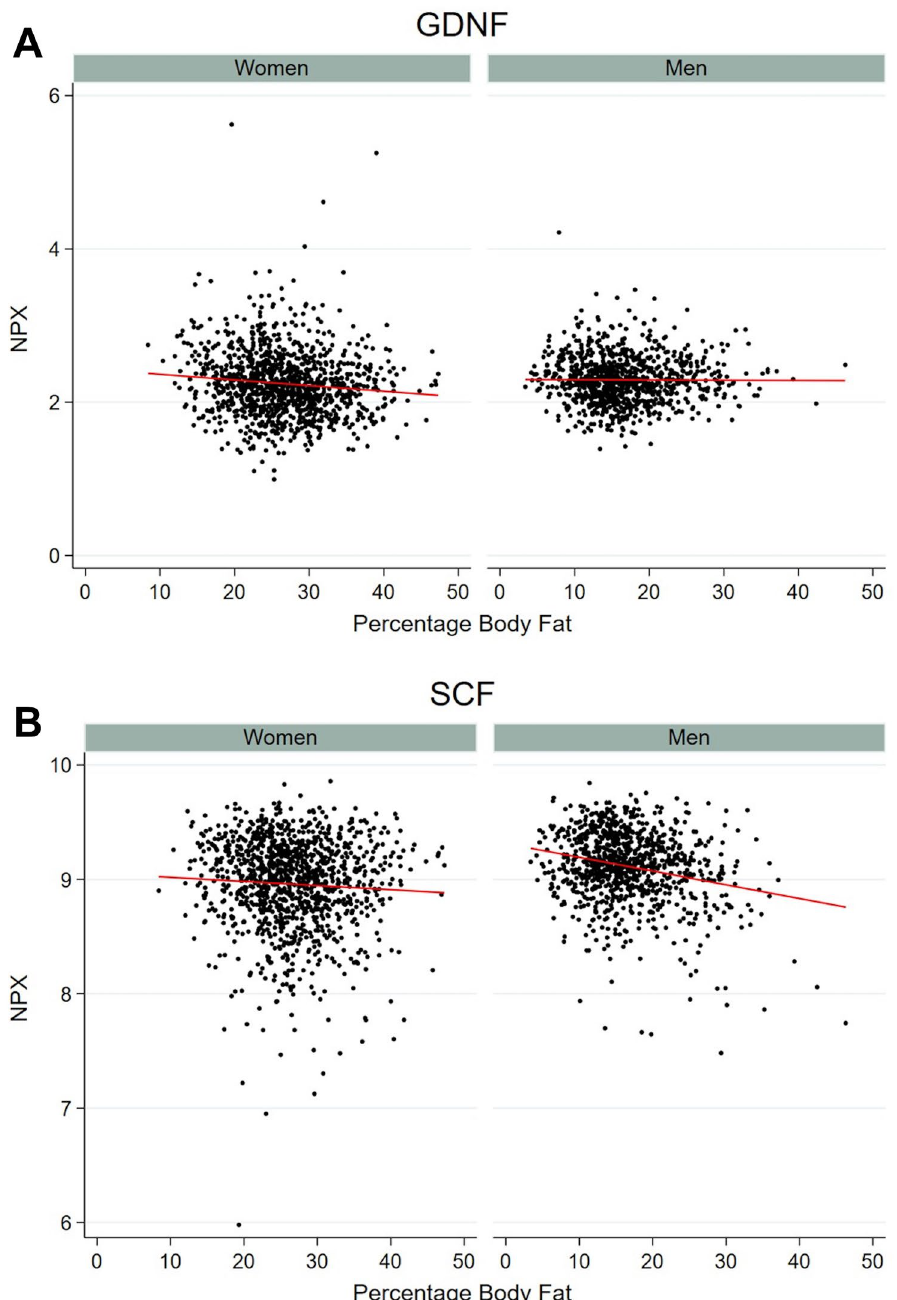
Figure 3. Examples of effect modification by sex. GDNF ( A ) and SCF ( B ) and association with %BF in females and males. Scatterplot and regression line of protein levels (in NPX) and %BF in females and males